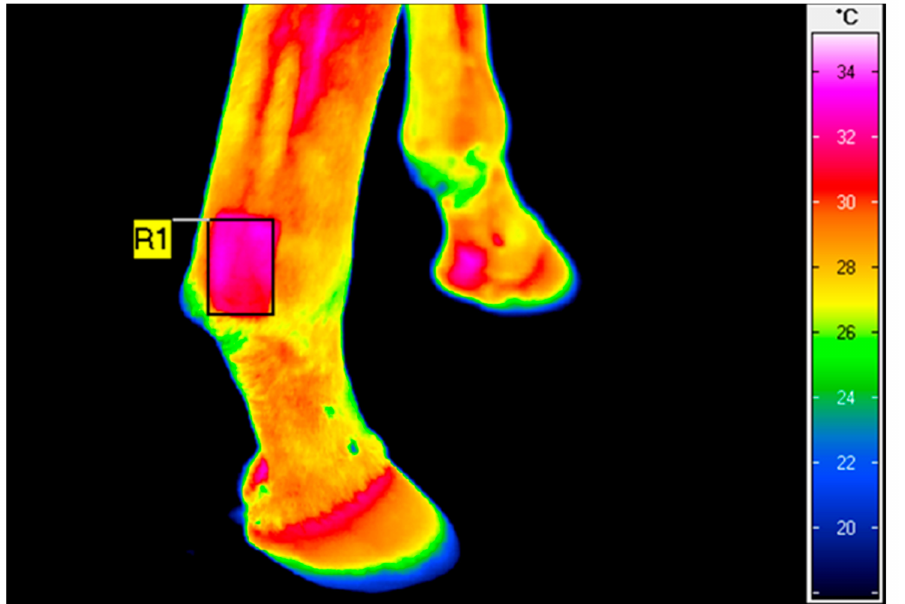
Figure 1. Example of thermographic image of the lateral aspect of the right non-pigmented hindlimb fetlock joint taken after HILT. The rectangular area (R1) indicates the average surface temperature of 31.7 ◦ C.